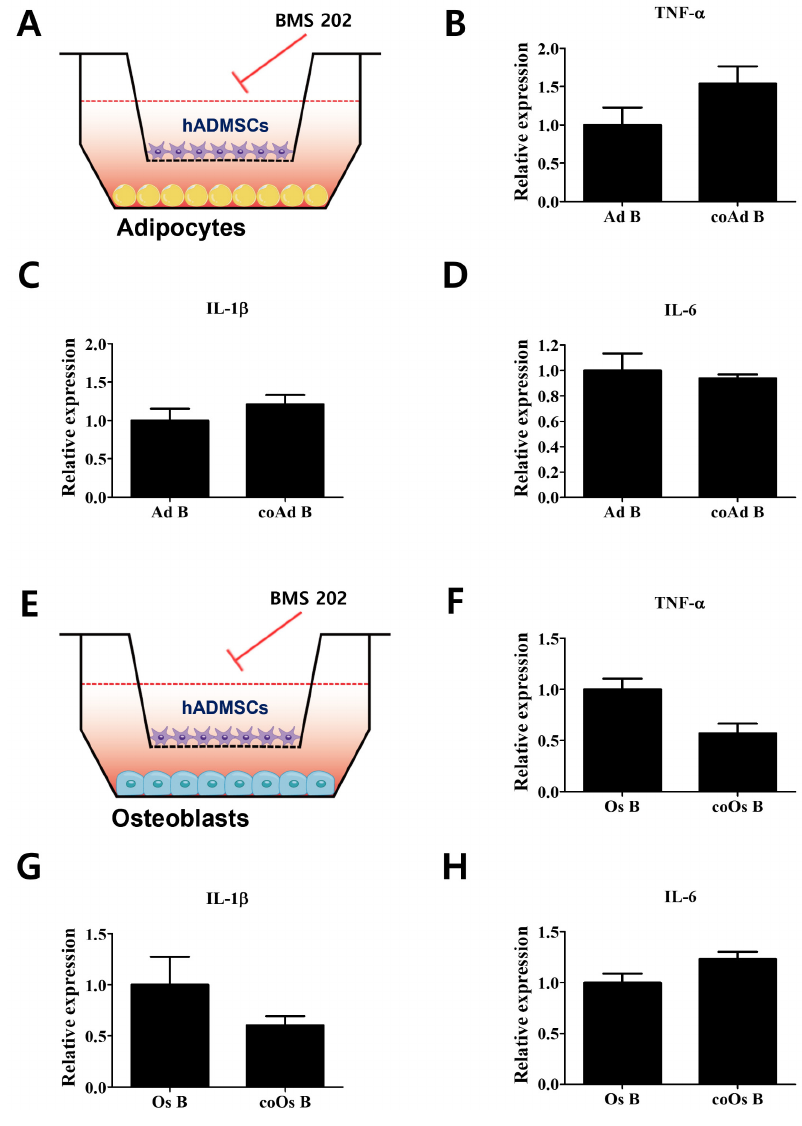
Figure 3. Attenuation of proinflammatory cytokine expression by PD-1/PD-L1 axis inhibition in differentiated cells cocultured with hADMSCs. ( A ) PD-1/PD-L1 interaction was inhibited in differentiated adipocytes cocultured with hADMSCs. Relative mRNA expression levels of ( B ) TNF- α , ( C ) IL-1 β , and ( D ) IL-6 . ( E ) PD-1/PD-L1 interaction was inhibited in differentiated osteoblasts cocultured with hADMSCs. Relative mRNA expression levels of ( F ) TNF- α , ( G ) IL-1 β , and ( H ) IL-6 . N = 3 trials per sample and control. Data are presented as mean ± SEM. hADMSCs: human adipose-derived mesenchymal stem cells; Ad: adipocytes; coAd: cocultured adipocytes; Os: osteoblasts; coOs: cocultured osteoblasts; B: BMS 202 (10 μ M).